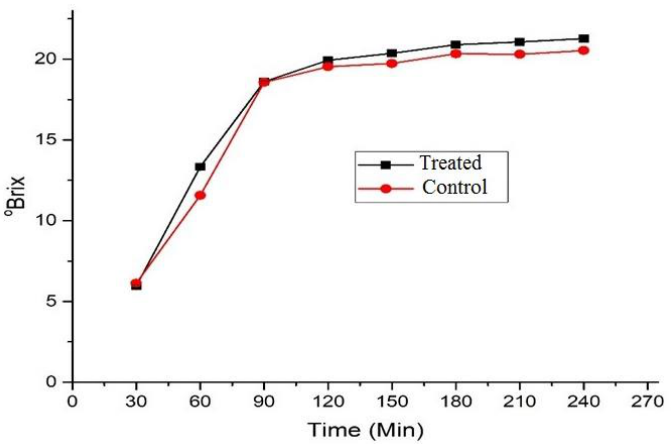
Figure 3. ◦ Brix of the mash during the mashing of Figure 3. °Brix of the mash during the mashing of processes.